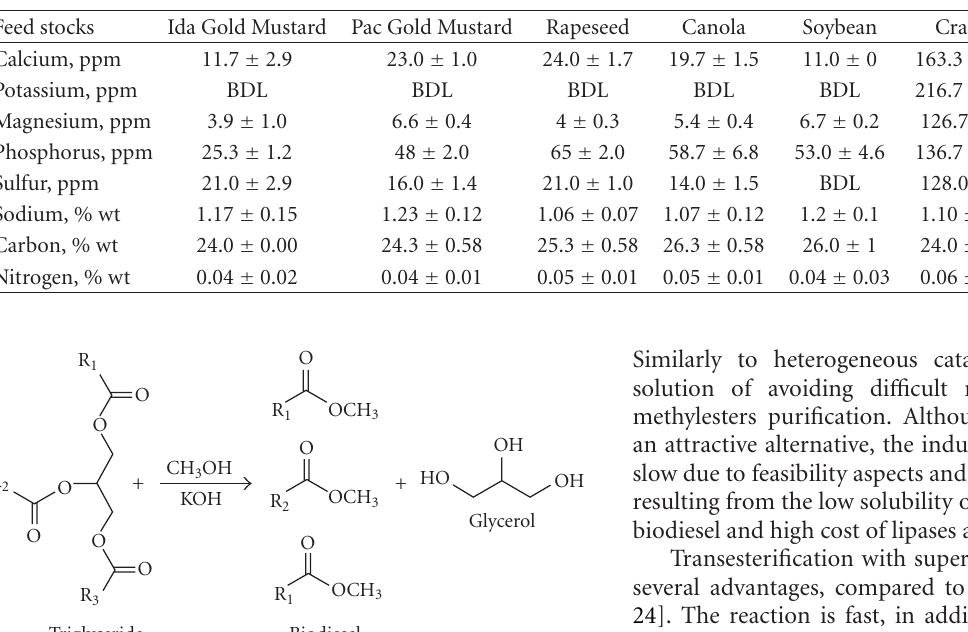
Table 1: Analysis results of macroelements, carbon and nitrogen in crude glycerol from di ff erent feedstocks (BDL indicates values that are below the detection limit for the corresponding analytical method) [25].